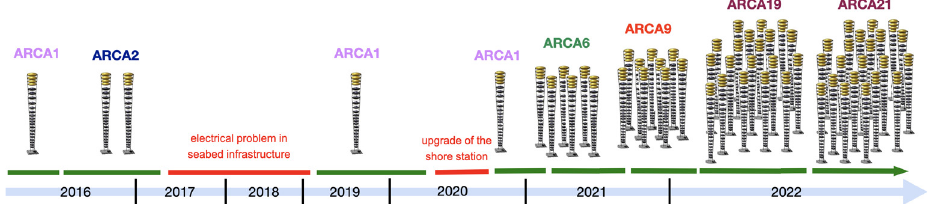
Figure 4. The ARCA detector is growing following the integration activities of the various elements, that are deployed during dedicated marine campaigns. Typically, two campaigns per year are performed, avoiding the winter period. Even if in partial configuration, ARCA is continuously taking data. Two long shutdown periods are reported in red: the first due to an electrical issue in the seabed infrastructure that was fixed with a complete redesign of the Junction Boxes, and the second related to a major upgrade of the shore station which was enlarged to support the full detector with two building